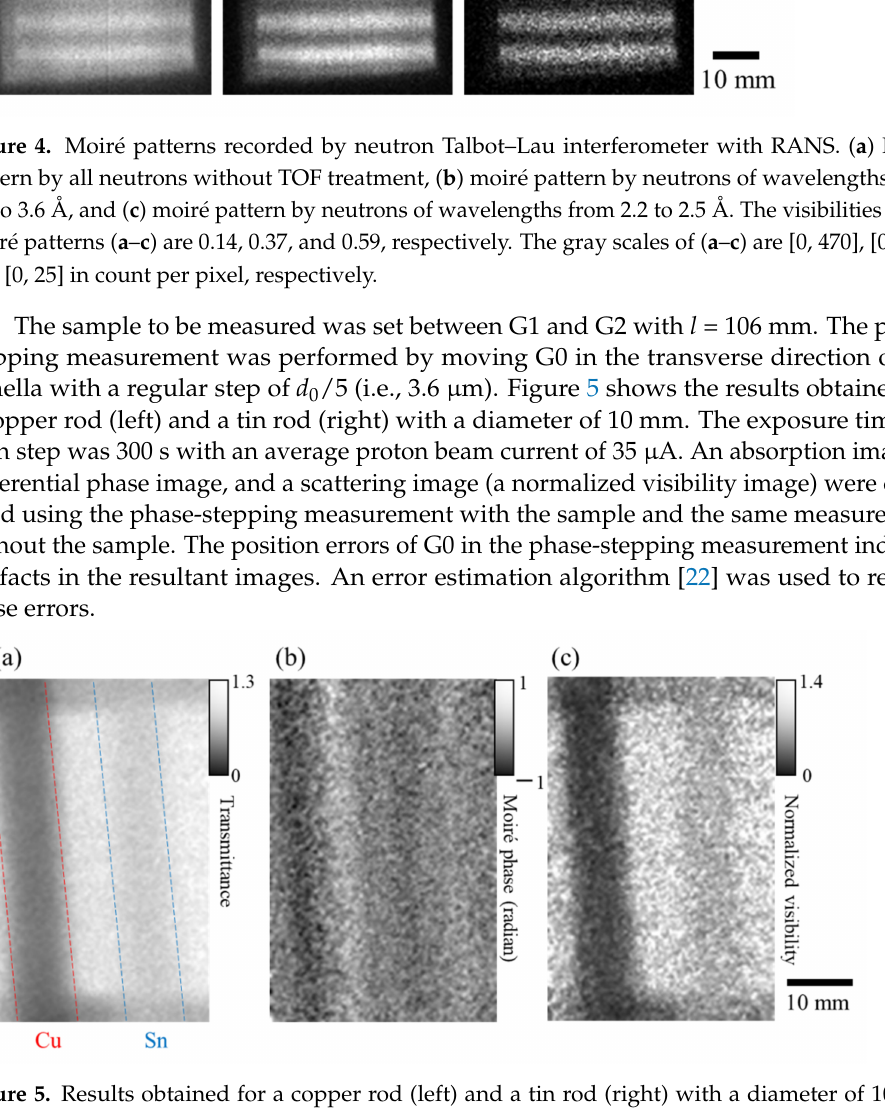
Figure 5. Results obtained for a copper rod (left) and a tin rod (right) with a diameter of 10 mm. ( a ) Absorption image, ( b ) moir é phase (differential phase) image, and ( c ) scattering (normalized visibility) image obtained by five-step phase-stepping measurement with exposure time of 300 s at each step. The images were generated by neutrons between 1.2 and 3.6